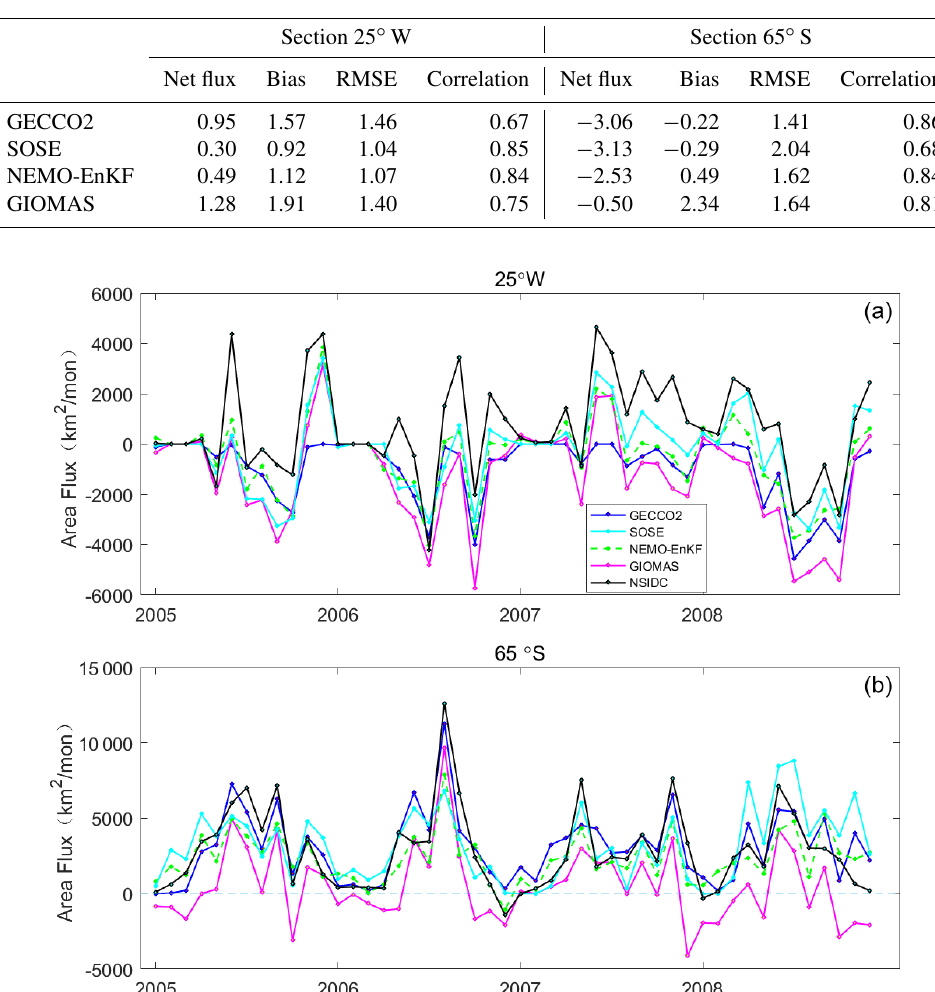
Figure 10. (a) Monthly sea-ice area flux westward into the southwestern Weddell Sea across the 25 ◦ W section and (b) area flux northward out of the southwestern Weddell Sea across the 65 ◦ S section from 2005 to